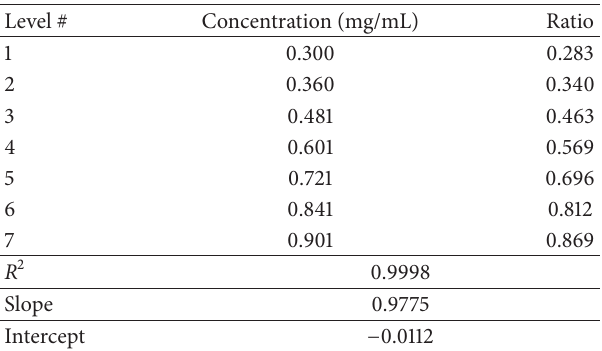
Figure 3: Linearity for menthol in suppository. Table 3: Linearity results for menthol.